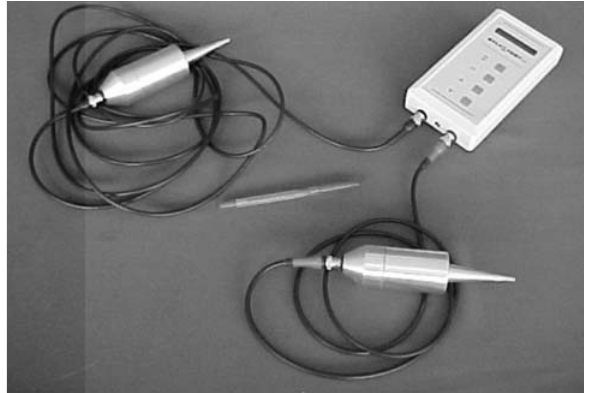
Figure 2. SYLVATEST ultrasound